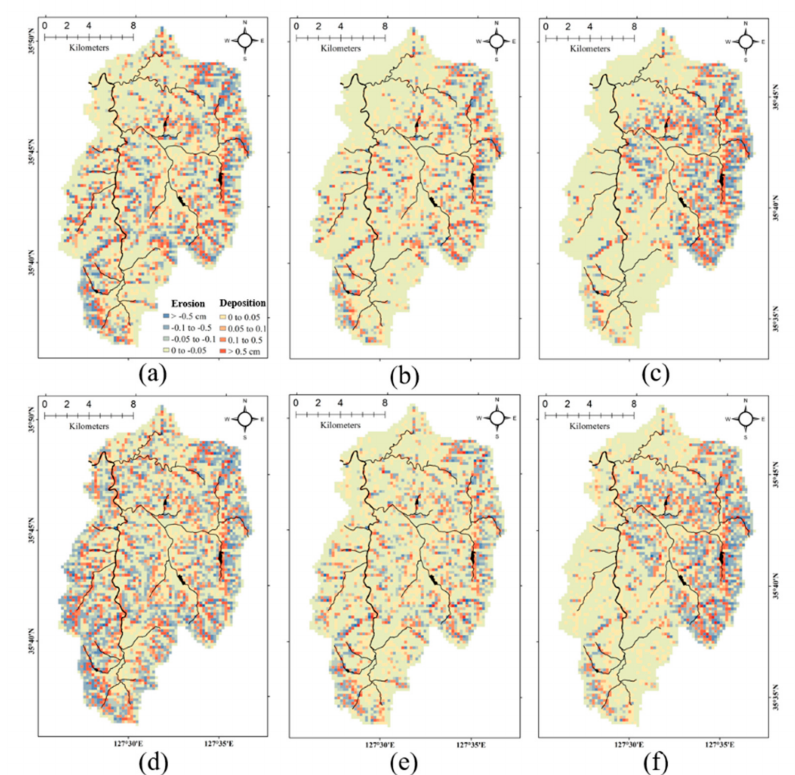
Figure 6. Spatial-temporal distribution of erosion/deposition maps predicted by the KR method in Event 1 ( a ), Event 2 ( b ), and Event 3 ( c ); and by the EH method in Event 1 ( d ), Event 2 ( e ), and Event 3 ( f